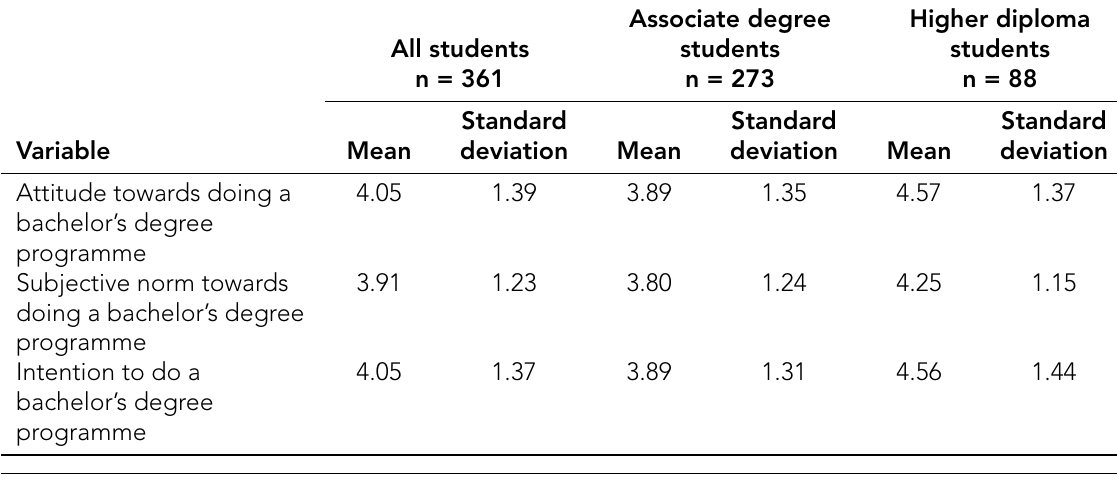
Table 3. Means and standard deviations of variables (Source: Authors, 2022)